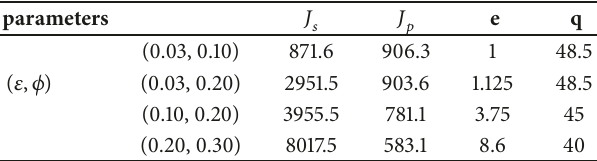
Table 2: Impacts of 𝜀,𝜙 on the optimal results.